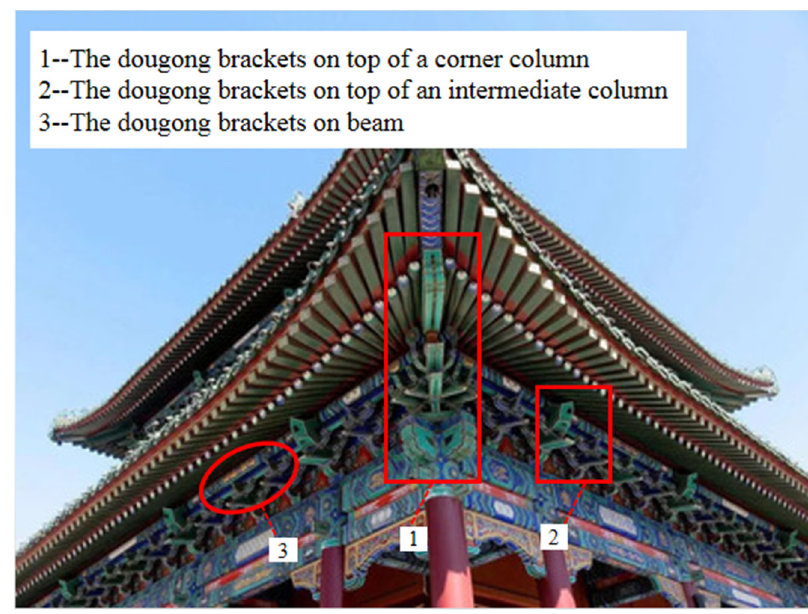
Figure 9. Types of Dougong bracket.